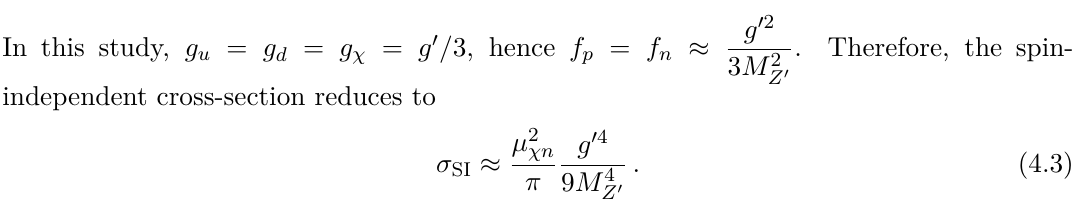
Figure 1 . Feynman diagrams leading to dark matter annihilation in the thermal freeze-out process (left) and dark matter direct detection